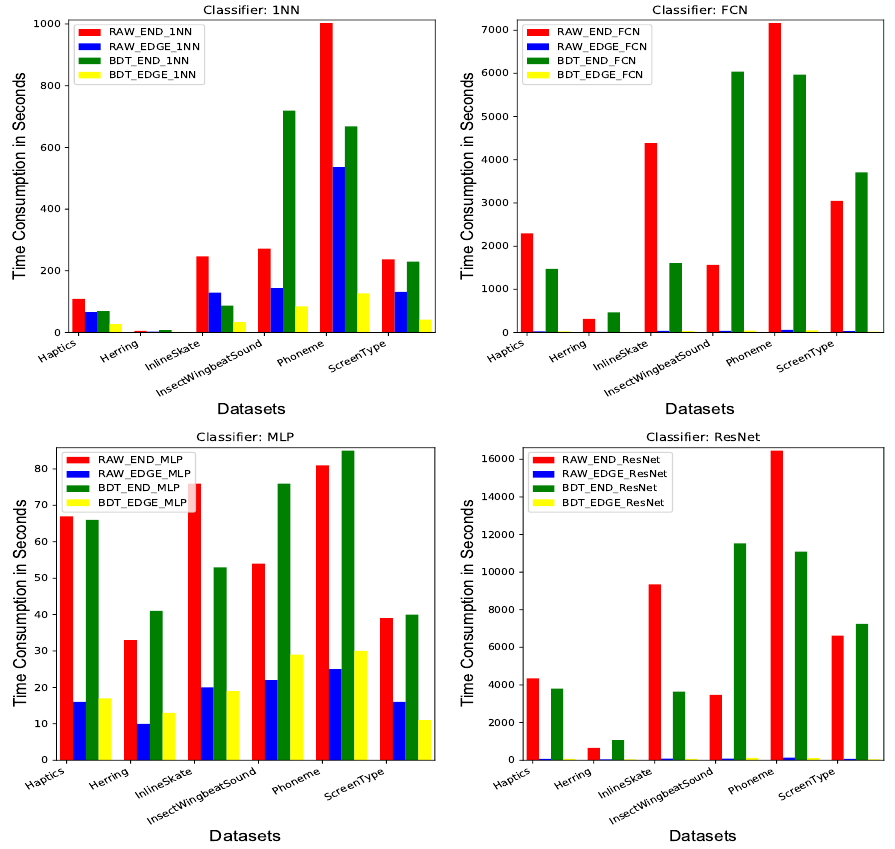
Figure 6. Time consumption of end device and edge device. 1NN =